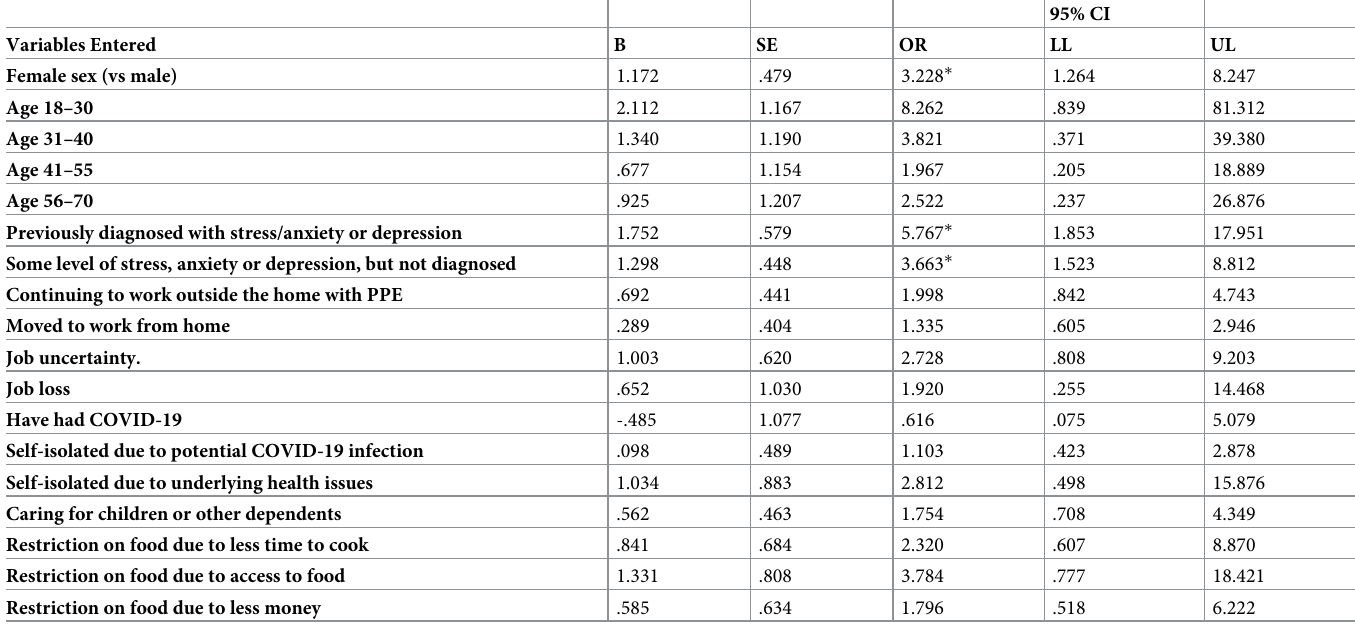
Table 6. Coefficients of the predictive model for high stress (PSS score = 20 or